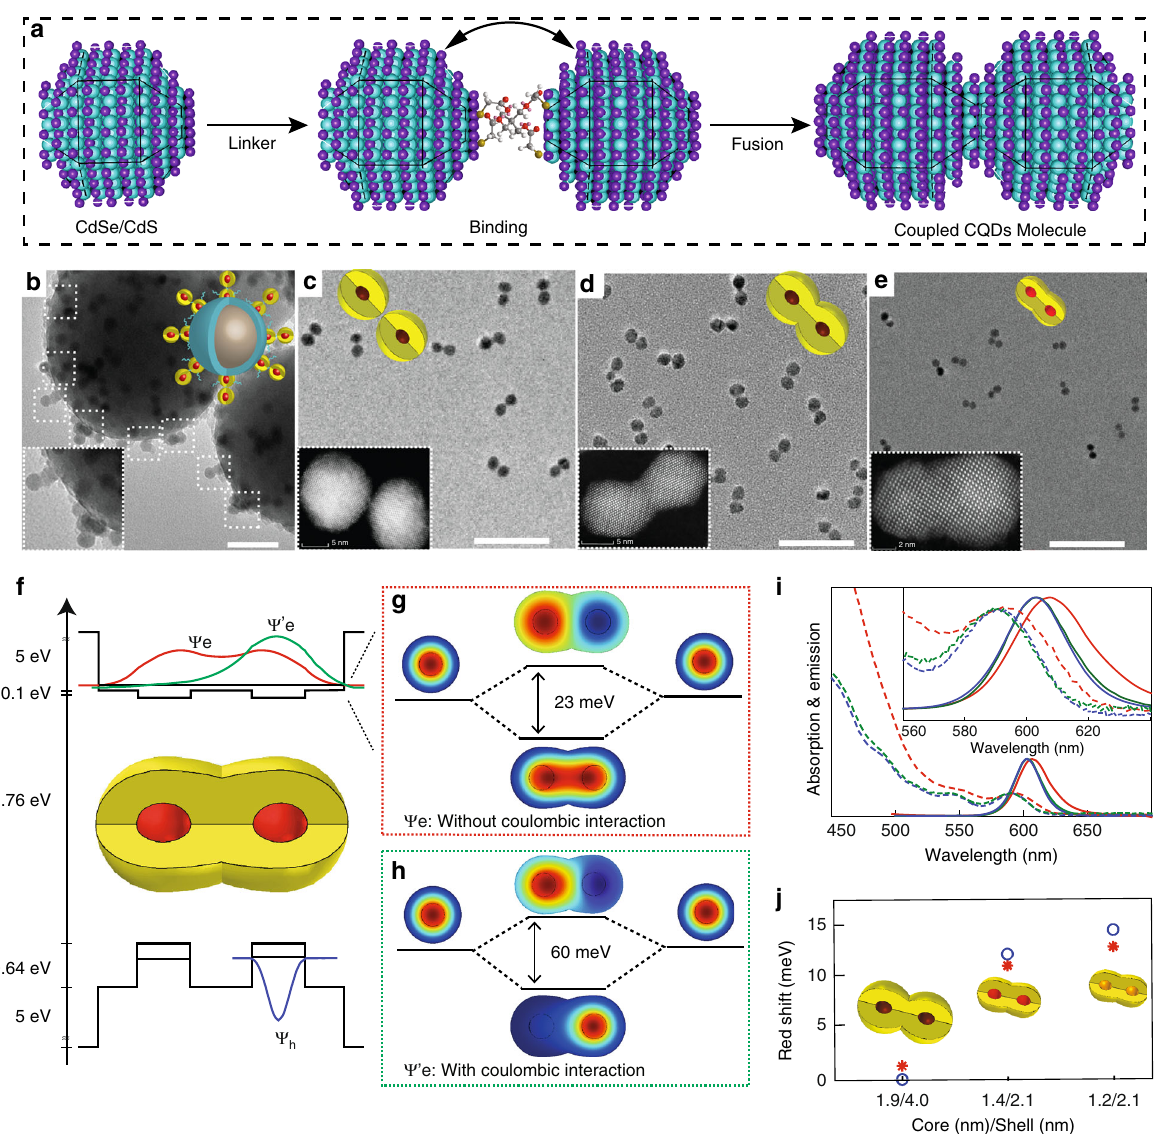
Fig. 1 Coupled CQD molecules. a Scheme for fabrication of coupled CdSe/CdS CQD molecule. b The dimer@SiO 2 CQD structure. The dimer 1.9/4.0 nm CQD molecules c before and d after the fusion procedure. e The 1.4/2.1 nm fused CdSe/CdS CQD molecules. Schematic structures are illustrated. Scale bars ( b – e ) are 50 nm and insets show higher magni fi cation images. f The potential energy landscape and a cross-section of the calculated fi rst electron wave function without Coulombic interaction Ψ (red), with Coulombic interaction Ψ 0 (green) and of the hole wave functions Ψ (blue) of the coupled CQD e h e molecules. g Calculated bonding and anti-bonding two-dimensional electron wave functions without (cross-section of the bonding state is the red curve in f ), and h with Coulombic interaction (cross-section of the bonding state is the green curve in f ). i Absorption (dashed lines) and fl uorescence spectra (solid lines) of monomers (blue), unfused (green), and fused 1.4/2.1 nm CdSe/CdS CQD molecules (red). j Calculated (red asterisk) and experimental (blue circles) band gap redshift of monomer-to-respective-homodimer structures for CQD molecules with different core/shell